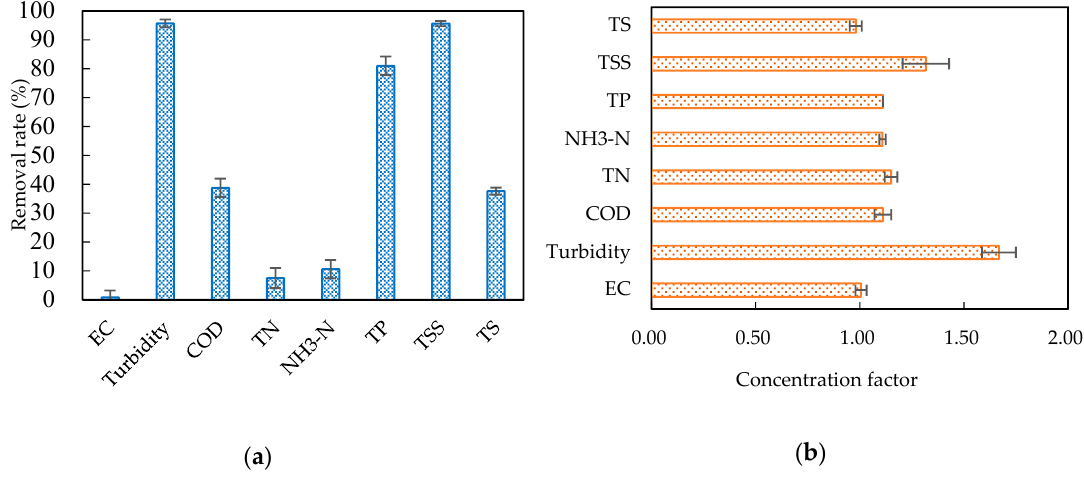
Figure 4. The removal rates in the permeate ( a ) and the concentration factors in the concentrate ( b ), compared with the initial separation liquid.